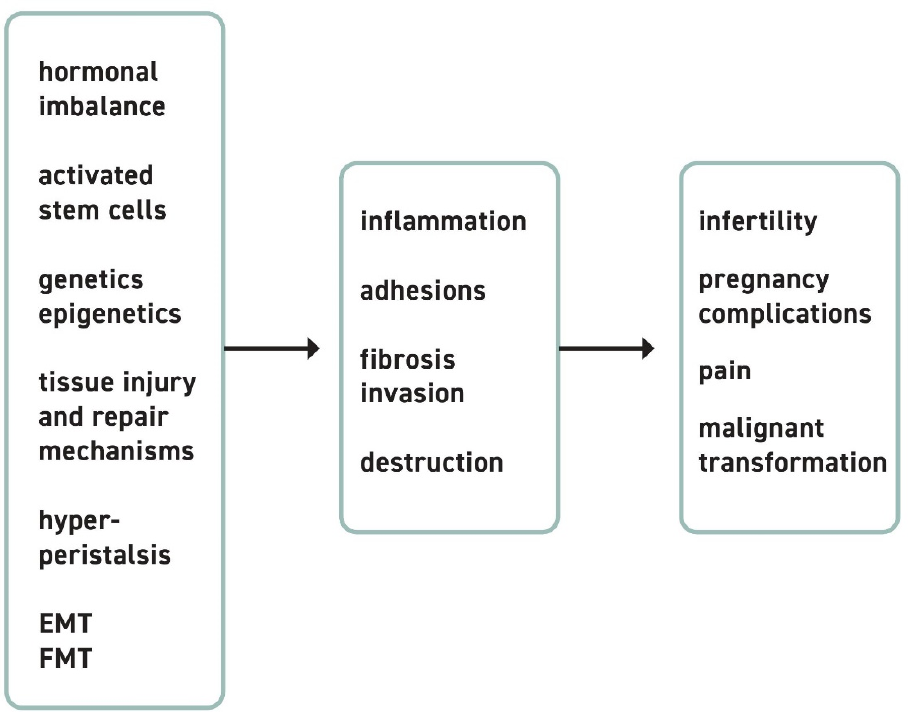
Figure 1. Pathophysiological pathways and clinical consequences. The underlying biological key concepts of EM include hormonal imbalance, activation of stem cells, changes on genetic and epigenetic levels, tissue injury and repair mechanisms, hyperperistalsis, epithelial-mesenchymal transition, and fibroblast to myofibroblast transition. In consequence, the formation of adhesions, fibrosis, inflammation, and local invasion arise. This coexistence of different pathways and their interactions triggers the clinical outcomes that affect multiple organ systems. EM patients present with complaints that include pain, infertility and sterility, complications in pregnancy, and even malignant transformation of preexisting lesions as ovarian cancer.